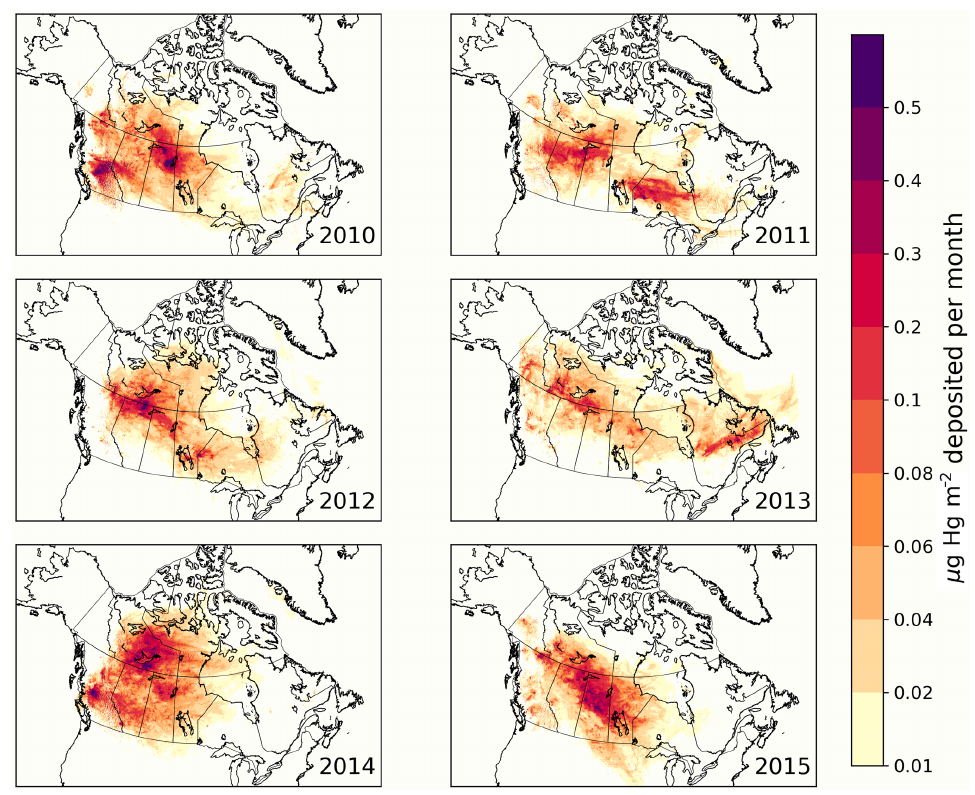
Figure 14. Average total atmospheric mercury deposition from biomass burning (prior with PBM biomass burning emissions scenario) in Canada during the burning season (May–September) for 2010–2015, given in µgm − 2